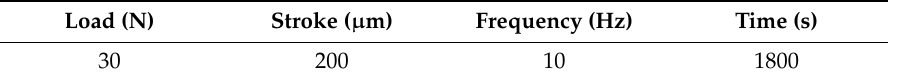
Table 2. Fretting wear parameters for specimens under di ff erent heat treatment conditions.